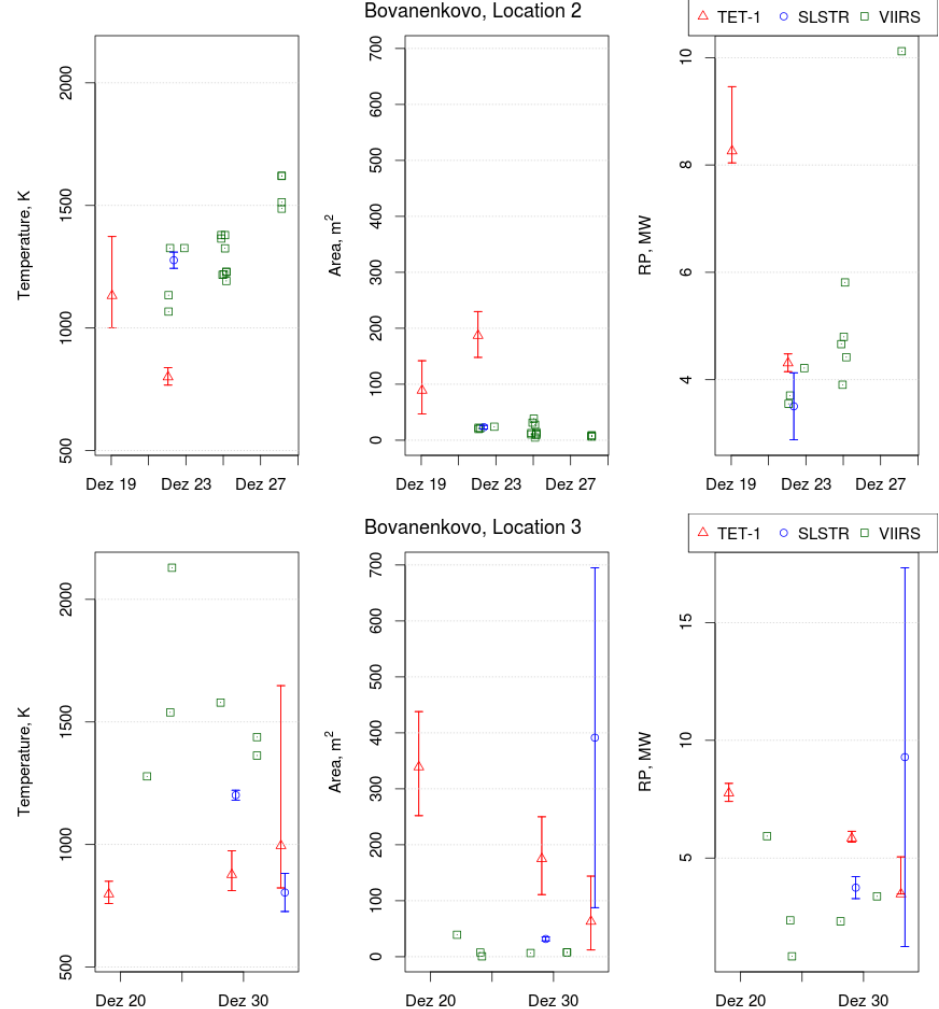
Figure 16. Temperature, area and radiative power determination for the detections at locations 2 and 3. Radiative power determinations based on VIIRS for a same overpass were added. The error bars reprent the bounds for TET-1 and the standard deviation for